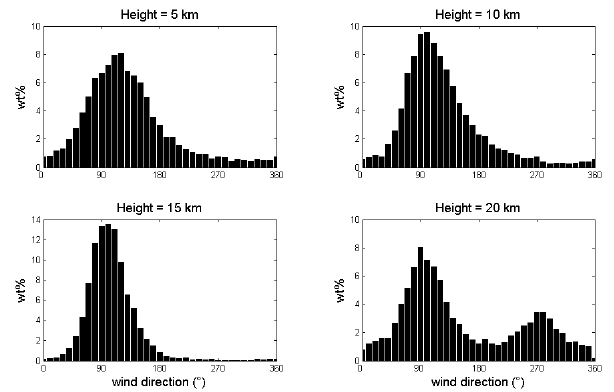
Fig. 8. Comparison between the grain-size distribution collected at Figure 8. Comparison between the grain-size distribution collected at Bronte (about 15 km 657 Bronte (about 15km from the vent) and computed by TEPHRA at from the vent) and computed by TEPHRA at the same locality. The Md  of the TGSD used in 658 the same locality. The Md ϕ of the TGSD used in the simulations the simulations was varied between -3 and 2.5  . The best agreement was obtained for Md  of 659 varied between − 3 and 2.5 ϕ . The best agreement was obtained for -0.5  . 660 Md ϕ of − 0.5 ϕ